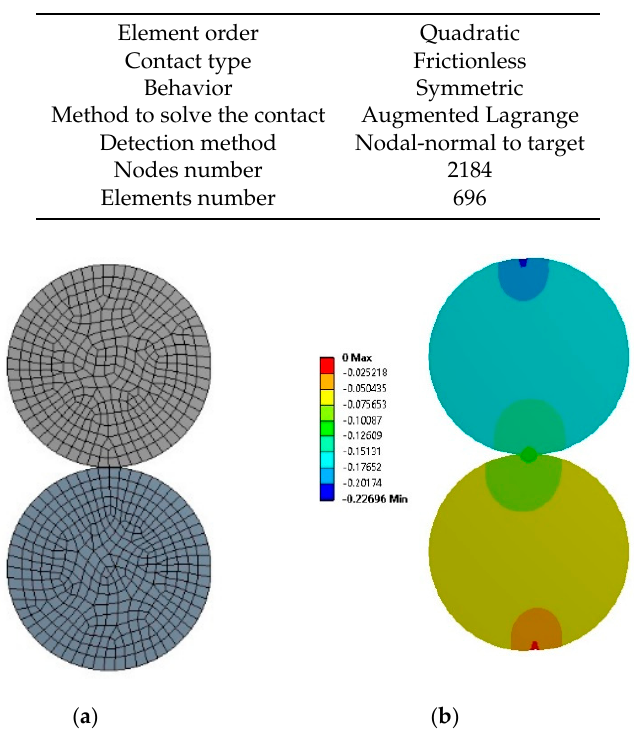
Figure 13. Contact between two bodies analyzed with FEM. ( a ) Mesh used in FEM software. ( b ) Contact between two bodies analyzed with FEM software; the plot colors represent the displacement in Y direction.